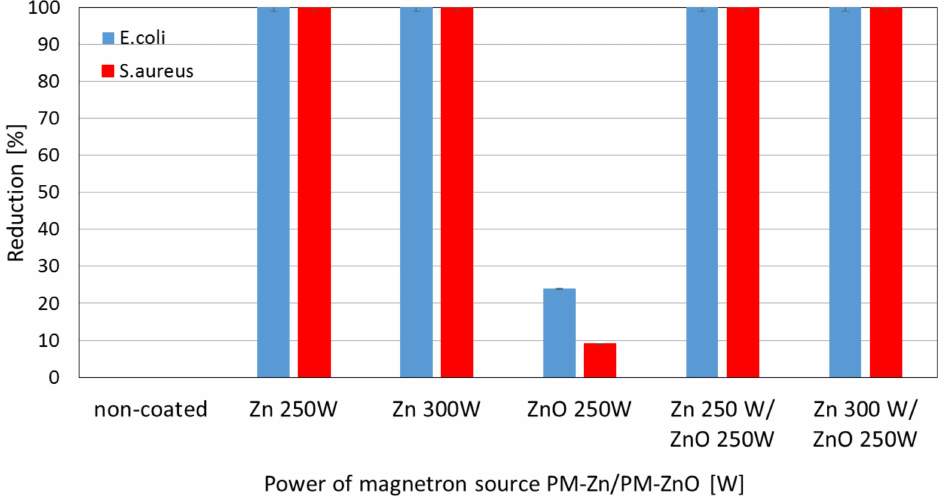
Figure 5. Reduction (%) in the viability of Escherichia coli and Staphylococcus aureus obtained for Zn and ZnO one-component coatings and Zn/ZnO two-component coatings deposited at different magnetron power sources (P M